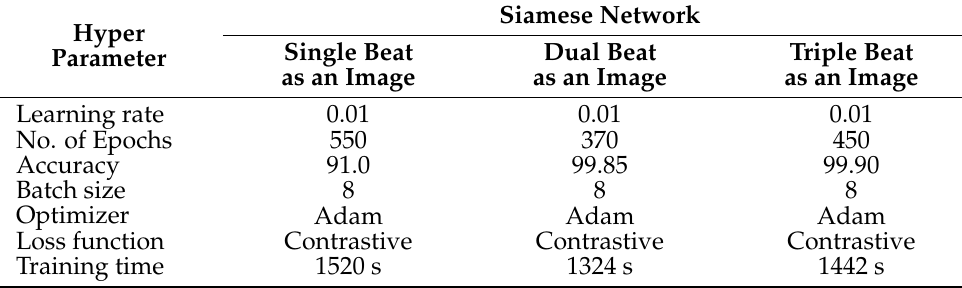
Table 5. Hyperparameter details of the proposed network.